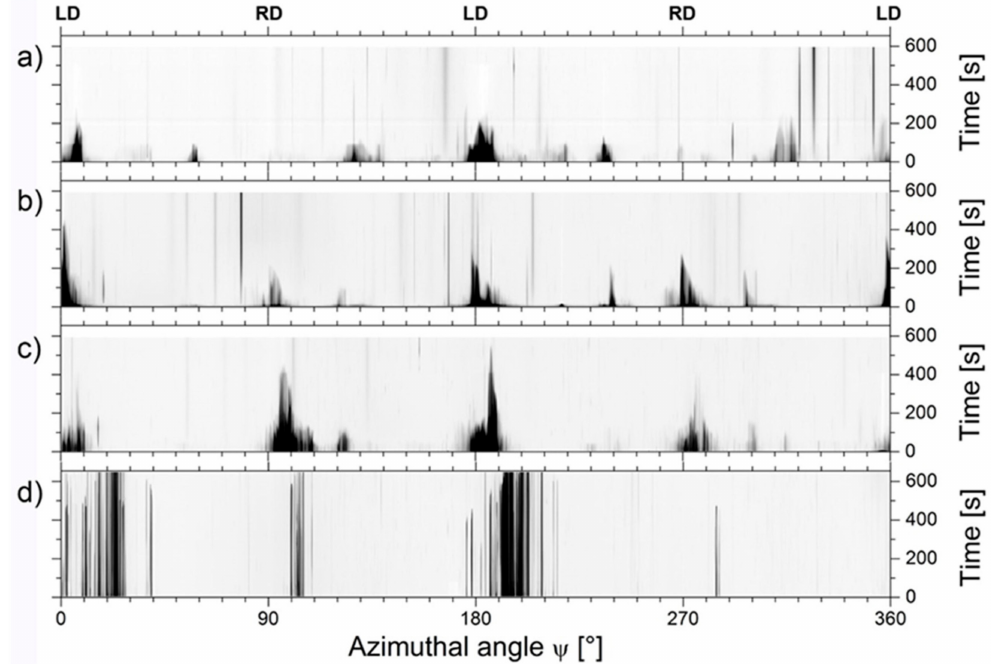
Figure 6. AT-plots for the β -200 crystallographic plane during isothermal heat treatment after deformation at strain rates of ( a ) 5 s − 1 , ( b ) 1 s − 1 , ( c ) 0.1 s − 1 , and ( d ) 0.001 s − 1 . Isothermal treatment time is indicated on the right. LD and RD correspond to the load and radial directions,